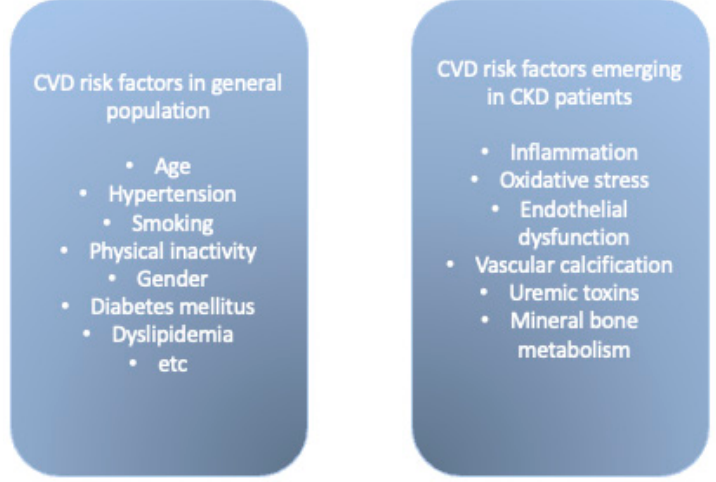
Figure 1. CVD risk factors in general population and in CKD patients.